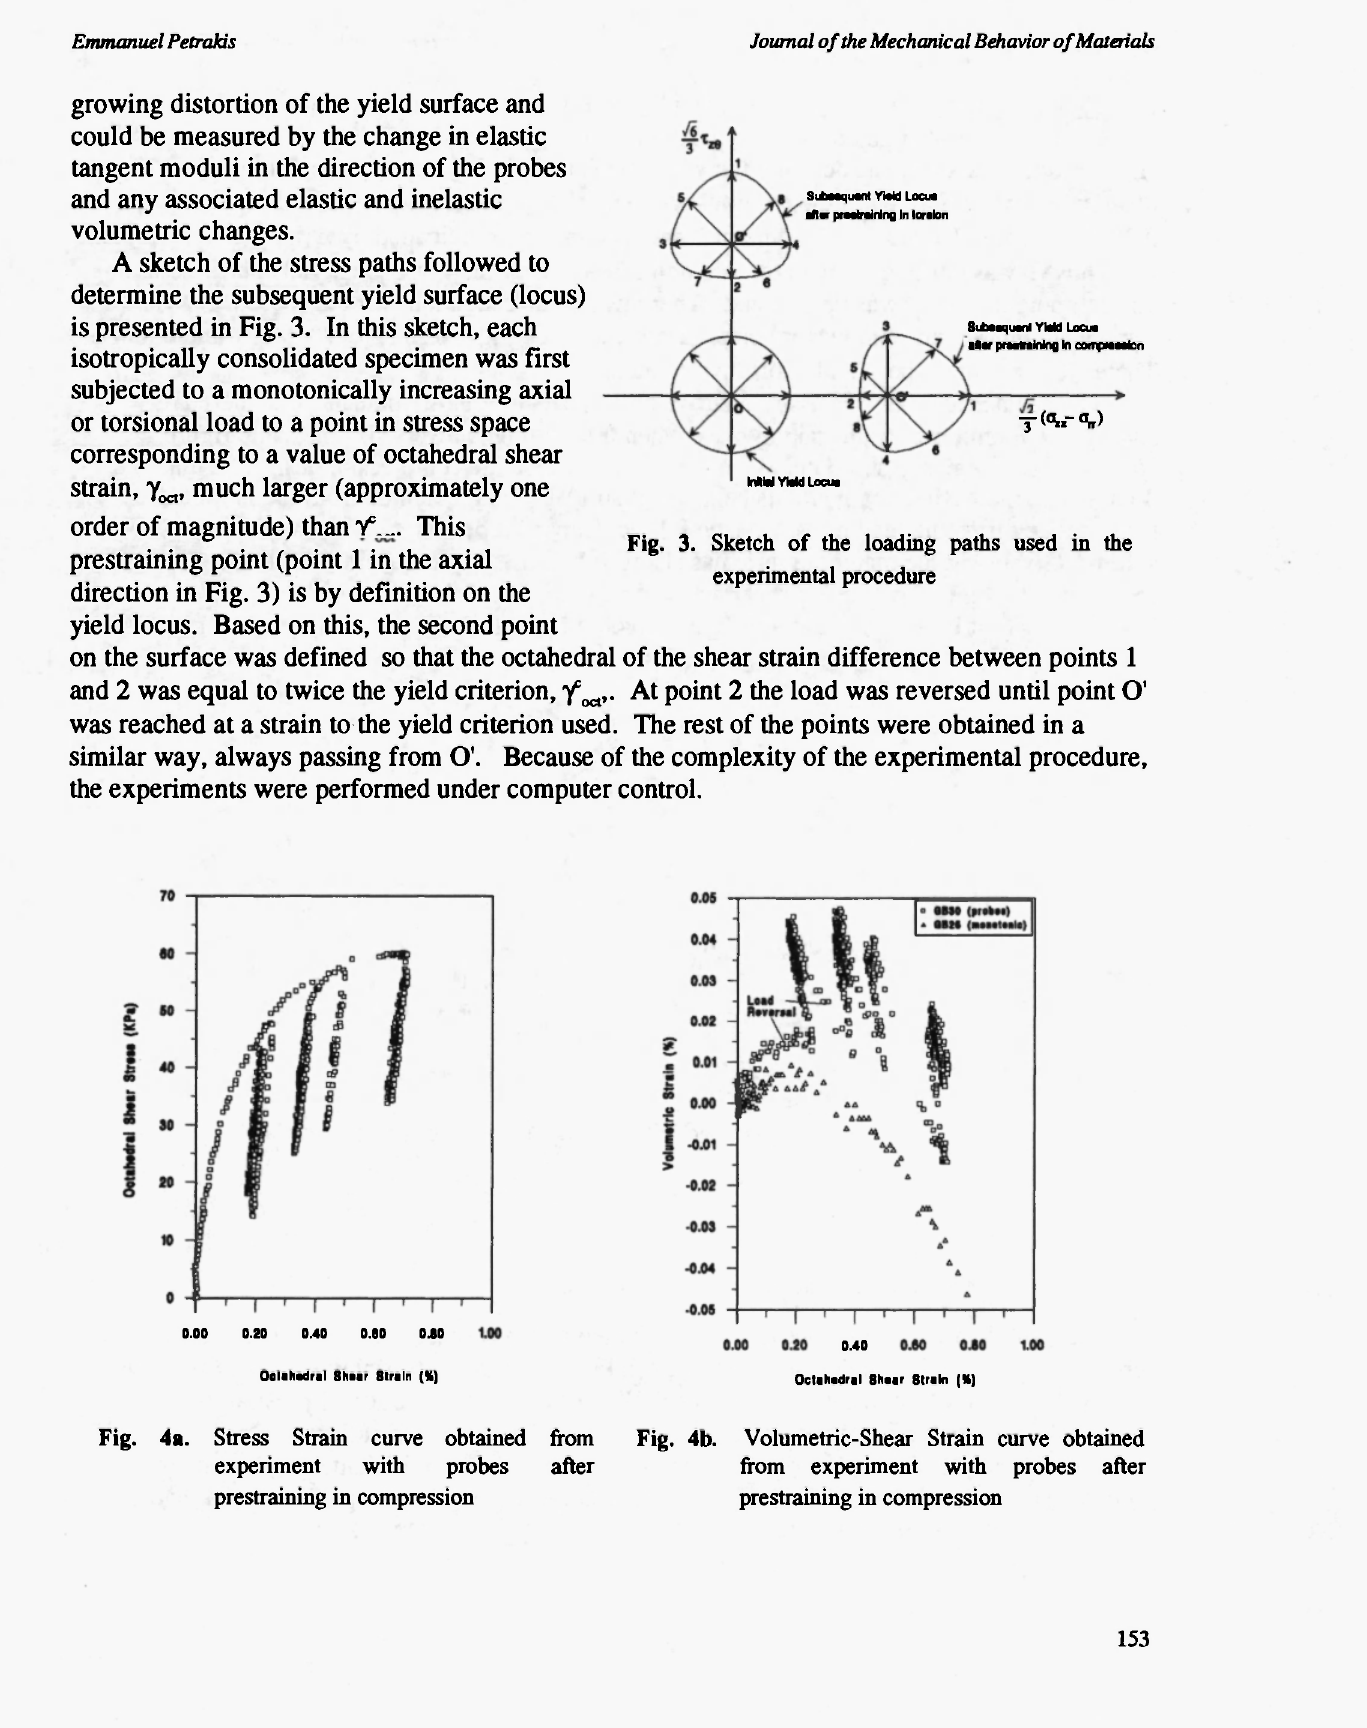
Fig. 4b. Volumetric-Shear Strain curve obtained from experiment with probes after prestraining in